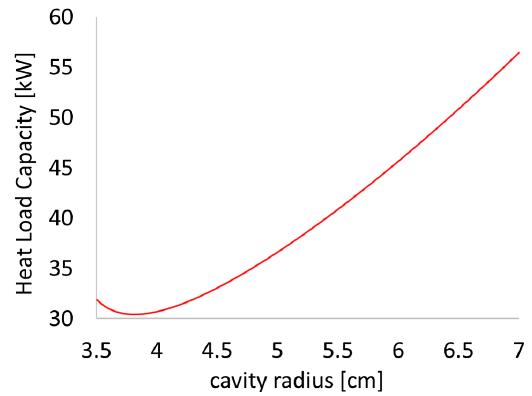
FIG. 8. Maximum average power that can be dissipated on TE 111 cavity walls versus radius of a 2.856 GHz cavity, when the average areal power is 100 W = cm 2 .